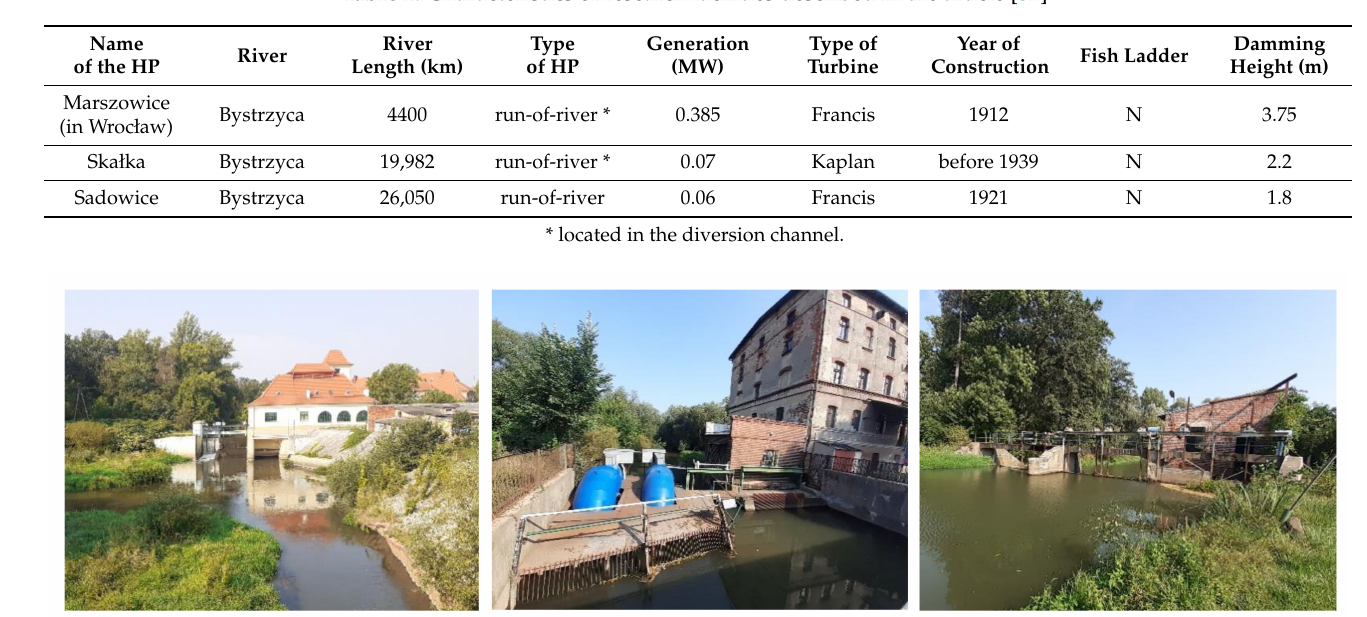
Table 2. Characteristics of research facilities described in the article [82].